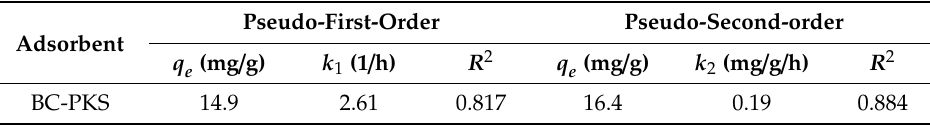
Table 1. Kinetics parameters for CV adsorption onto BC-PKS.